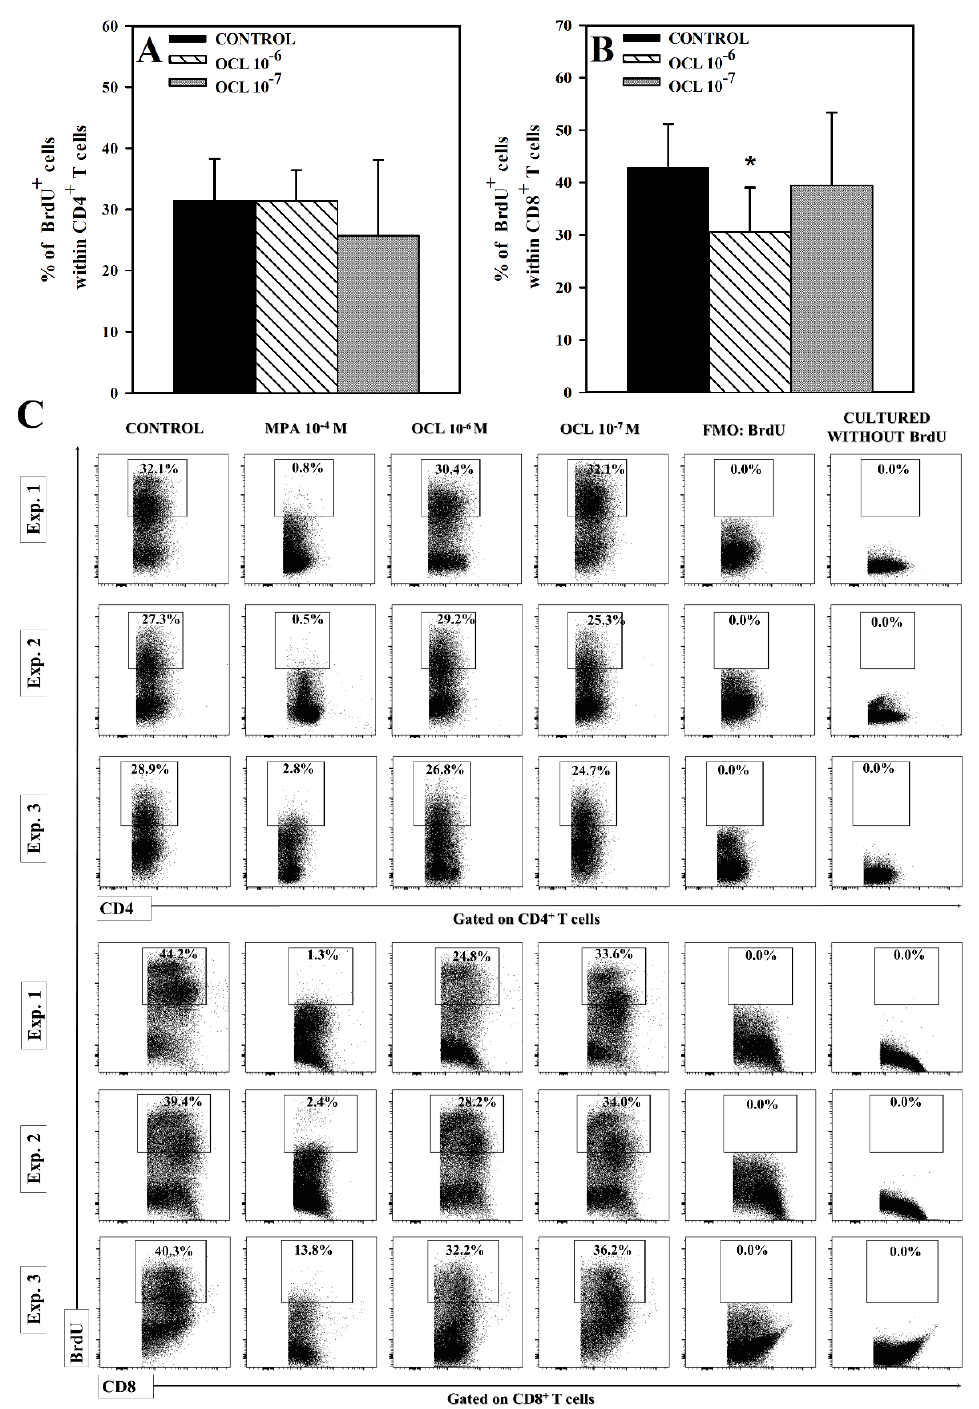
Figure 6. Effect of oclacitinib (OCL) on the proliferation of CD4 + ( A ) and CD8 + ( B ) T cells. The relative count of 5-bromo-2’-deoxyuridine(BrdU)-incorporating cells among CD4 + and CD8 + T cells was determined in cell cultures incubated with or without (control) OCL (10 − 6 M and 10 − 7 M). Results are the mean ( ± S.D.) of three independent experiments with 5 mice per experiment (overall n = 15, * p < 0.001, control cells vs OCL-treated (10 − 6 or 10 − 7 M) cells (Student’s unpaired t -test)). Examples of dot plot cytograms show the distribution of BrdU-positive and -negative cells within CD4 + and CD8 + T cell subsets ( C ). Fluorescence minus one (FMO) controls as well as cultured cells without BrdU were used to confirm the gating strategy used to identify BrdU + cells. Cells treated with mycophenolic acid (MPA, an active metabolite of the prodrug mycophenolate mofetil), i.e., the agent with the proved antiproliferative activity to T cells, constituted an additional negative as well as a reference